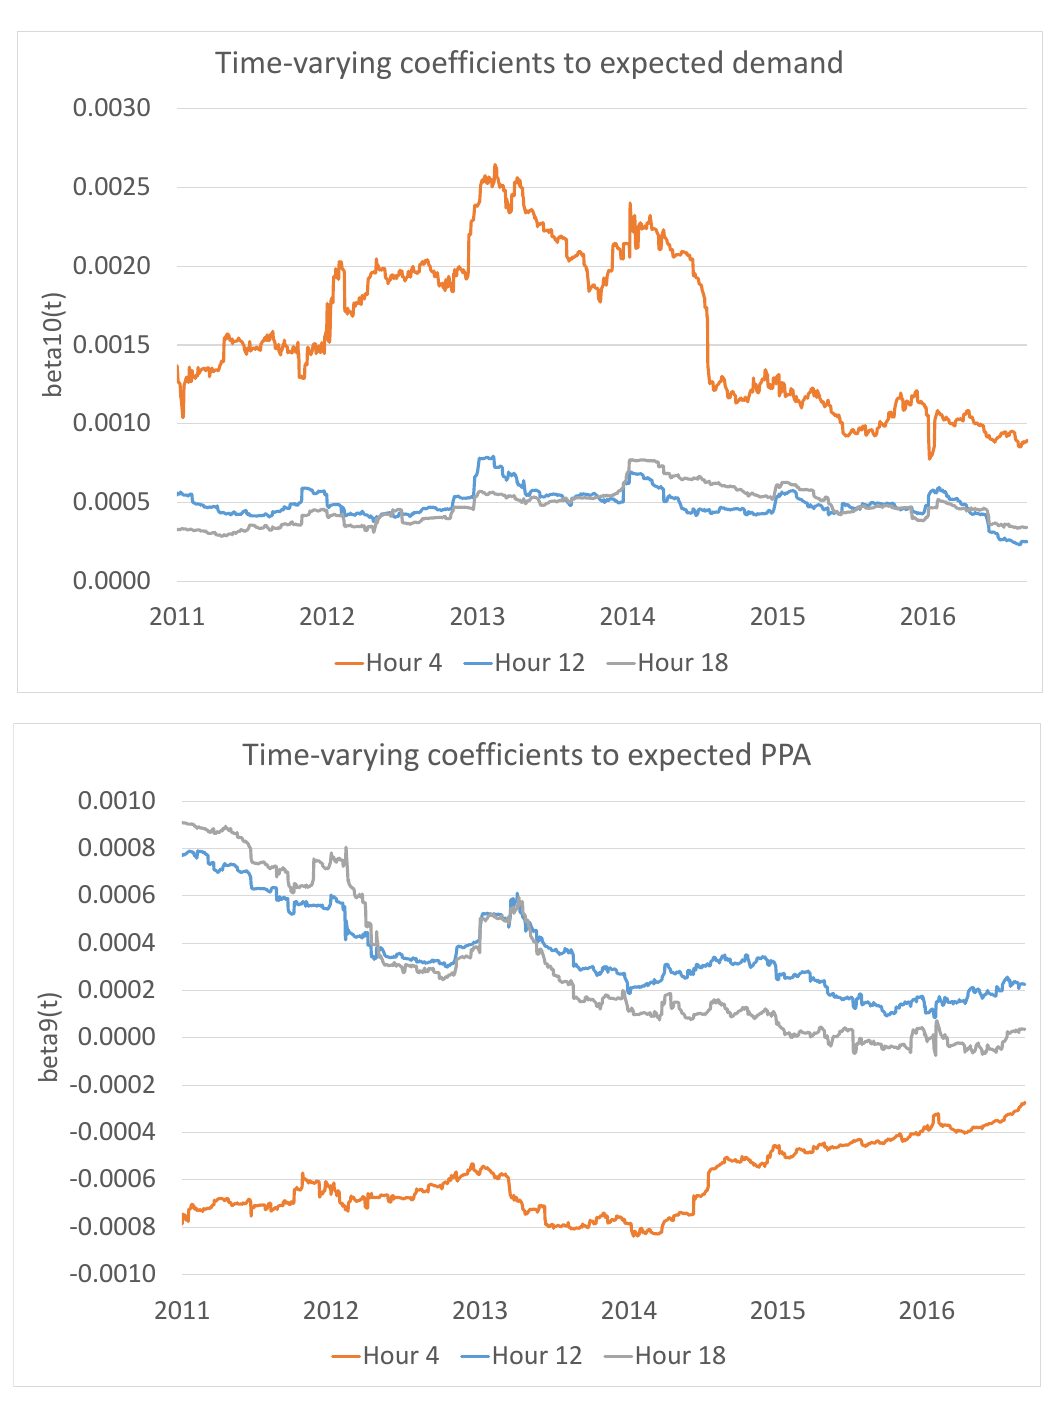
Figure 8. Time-varying coefficients of German demand and supply. The coefficients have been estimated for the sample period from 1 January 2011 until 31 August 2016 with respect to the key hours H4, H12 and H18 on working